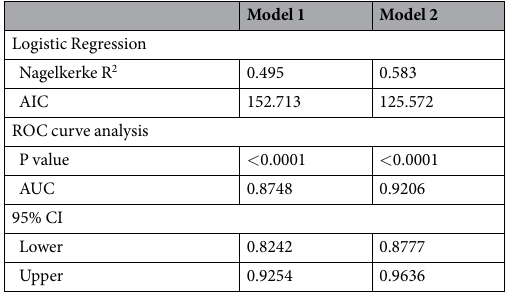
Table 5. Logistic Regression and ROC curve analysis of two different models for predicting Hemorrhagic MMD or MMS. Model 1: multivariate analysis of demographic and structural metrics (including,